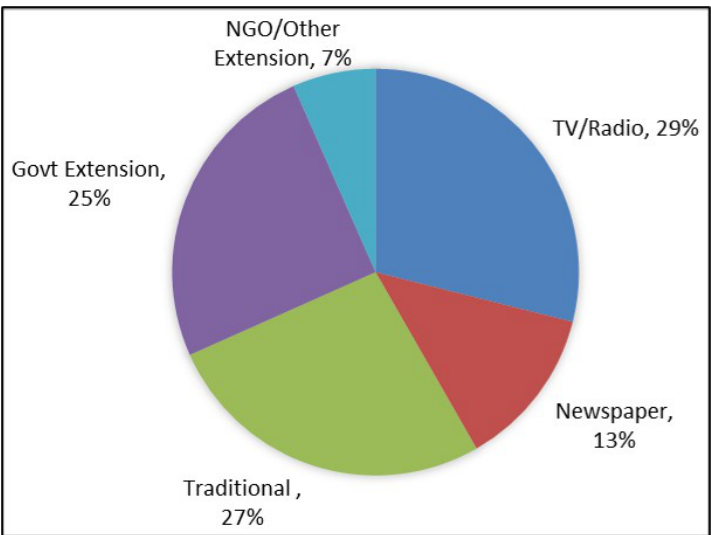
Figure 16. Access to information and forecasts irrespective of education